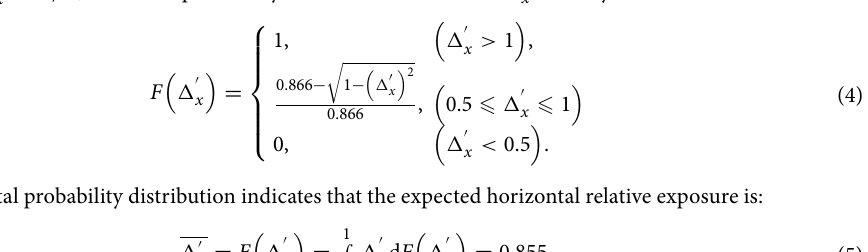
Relationship between the relative exposure degree and the drag force and lift force coeffi- cients of water flow. 2 (cid:31) z (cid:31) ′ z = D represent horizontal relative exposure and vertical relative exposure, respectively. Bai et al.